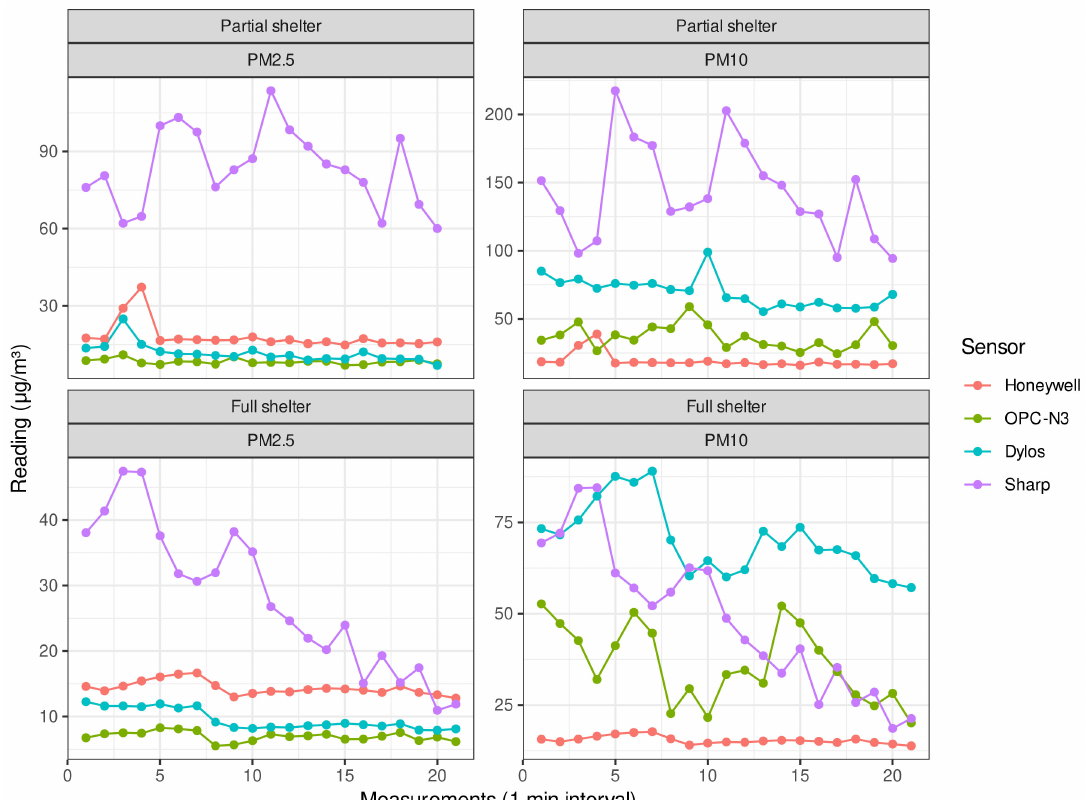
Figure 5. COTS Sensor readings over time under different exposure levels to